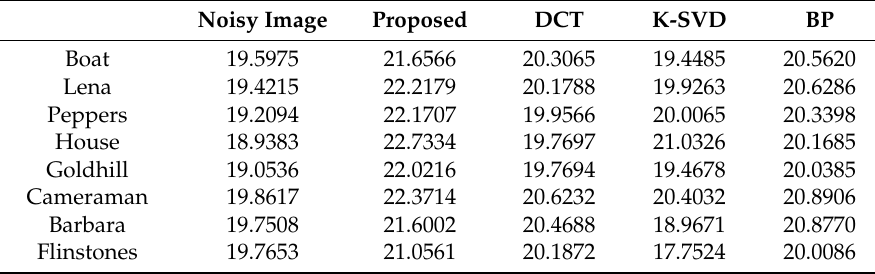
Table 4. Objective result comparison (in PSNR, dB) of the proposed method with